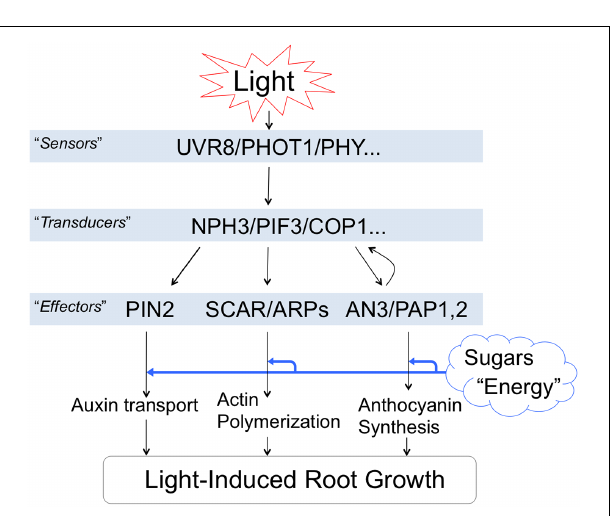
FIGURE 3 | Light environment affects sensitivity of Arabidopsis roots to salinity. Seedlings of Col-0 were firstly grown on 1/2 MS media for 5 days. Bottom part of agar was removed diagonally and new 1/2 MS media containing NaCl was added. Petri dishes were placed either in light or dark condition for 3 days. Roots growing on agar plates in dark/light conditions